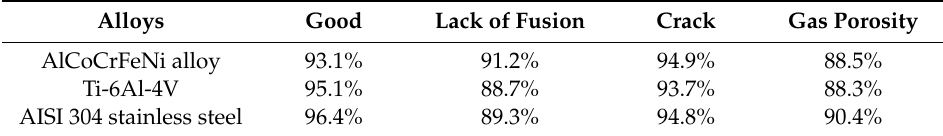
Table 8. Classification accuracy of di ff erent alloys in the test dataset.